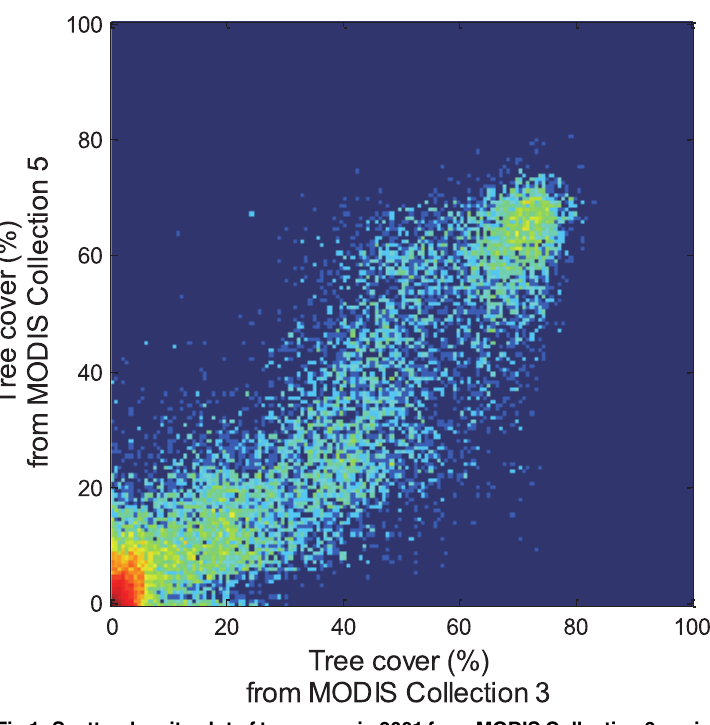
Fig 1. Scatter density plot of tree cover in 2001 from MODIS Collection 3 against Collection 5. Point density from low to high is indicated by the color gradient from blue to red.